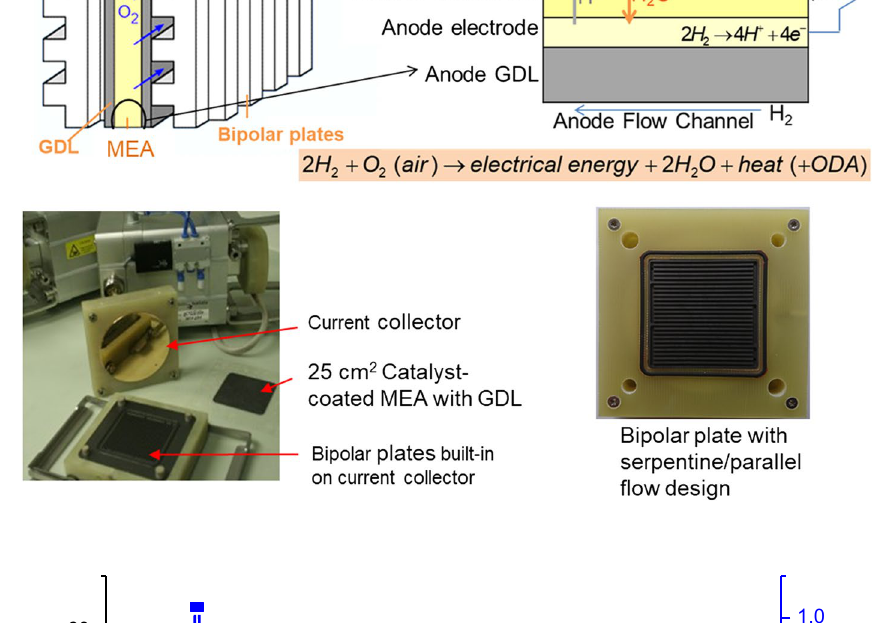
Fig. 2 Schematic diagram of SU/SD cycle (heating up to 60 °C and cooling down to room temperature) used during experimental part of the work. A voltage of 0.7 V was imposed during the heating and cooling. Voltage was measured at the imposed current when measur- ing IV curve and